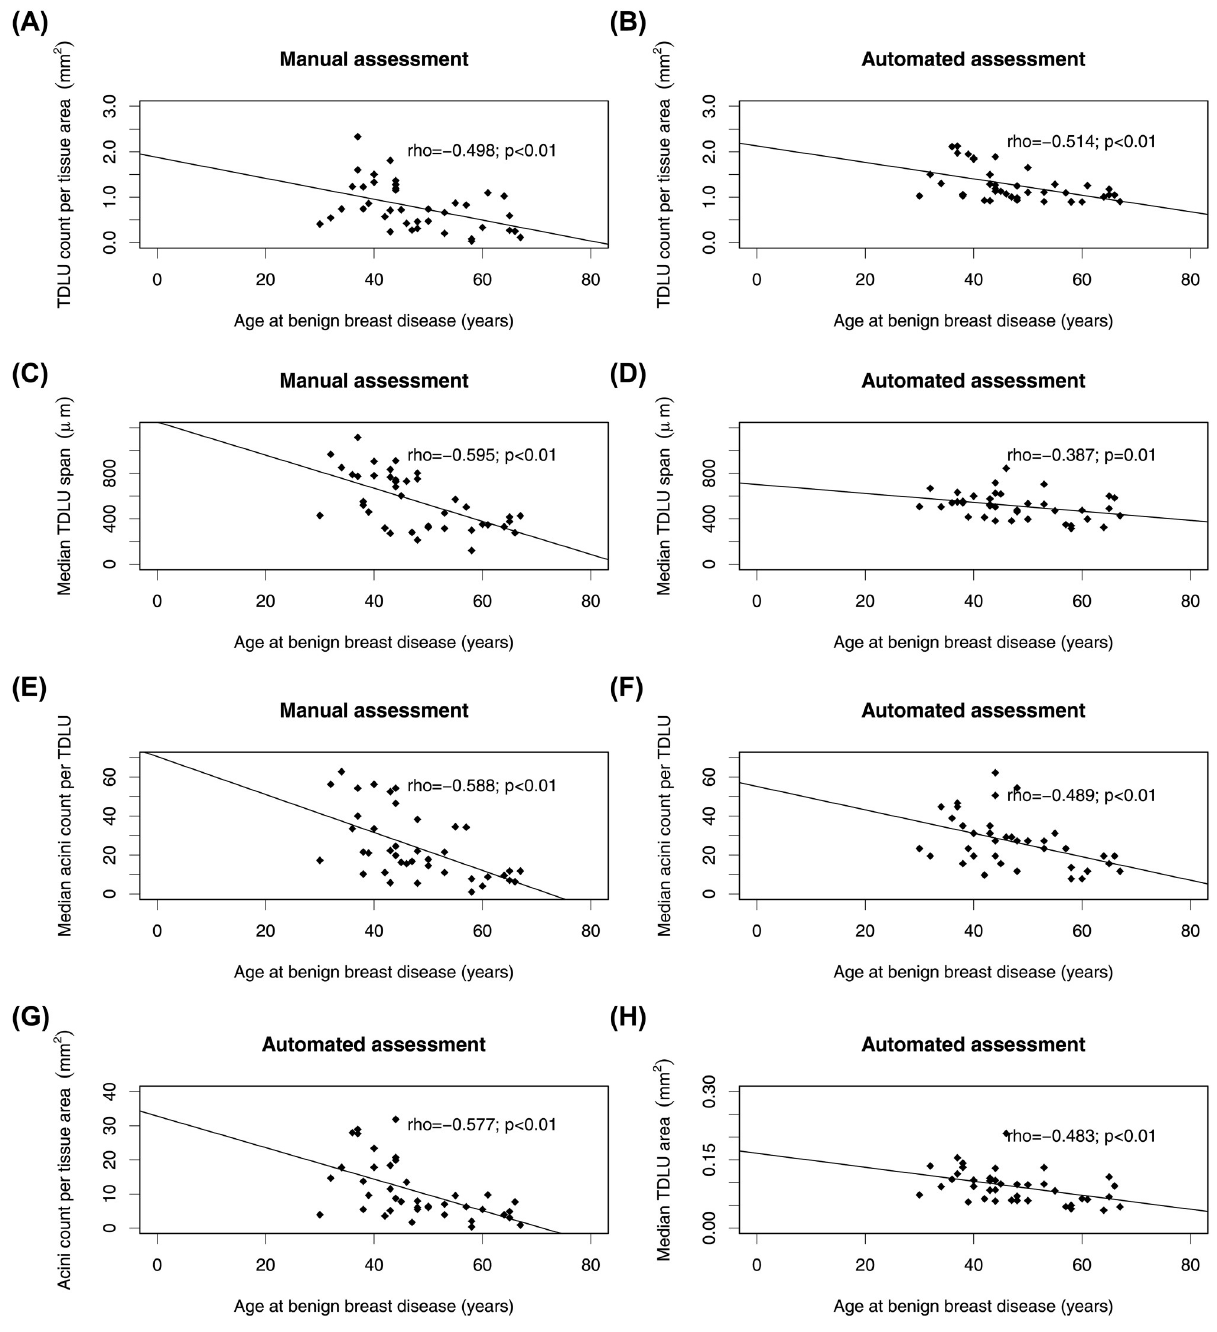
Fig 4. Scatterplots of the association of quantitative terminal ductal lobular unit (TDLU) involution measures and age. TDLU count per tissue area assessed using manual ( A ) and automated ( B ) method were significantly inversely correlated with age ( p < 0.01). Median TDLU span assessed manually ( C ) and with the automated method ( D ) was significantly inversely correlated with age ( p < 0.01 and p = 0.01). Median acini count per TDLU assessed using manual ( E ) and automated ( F ) assessment was also significantly inversely correlated with age ( p < 0.01). Acini count per tissue area assessed by the automated method was significantly inversely correlated with age ( G ; p < 0.01). Median TDLU area assessed by the automated method was significantly inversely correlated with age ( H ; p <